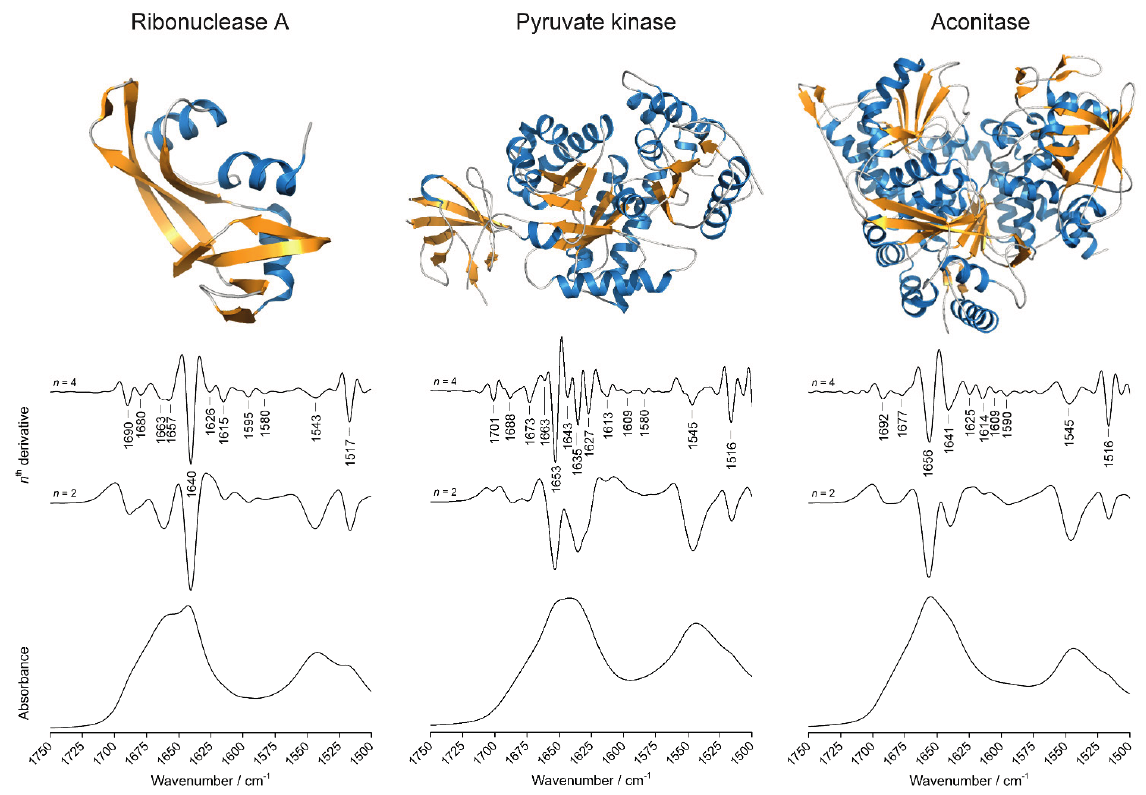
Figure 2. Three-dimensional structures, infrared absorption and derivative spectra (second and fourth) of ribonuclease A, pyruvate kinase, and aconitase. α -Helices and β -sheets are colored blue and orange, respectively. Irregular structure and turns are colored grey. Spectra from bottom to top: absorption, second derivative, and fourth derivative. Second derivative spectra are scaled arbitrarily. Fourth derivative spectra are scaled and multiplied by